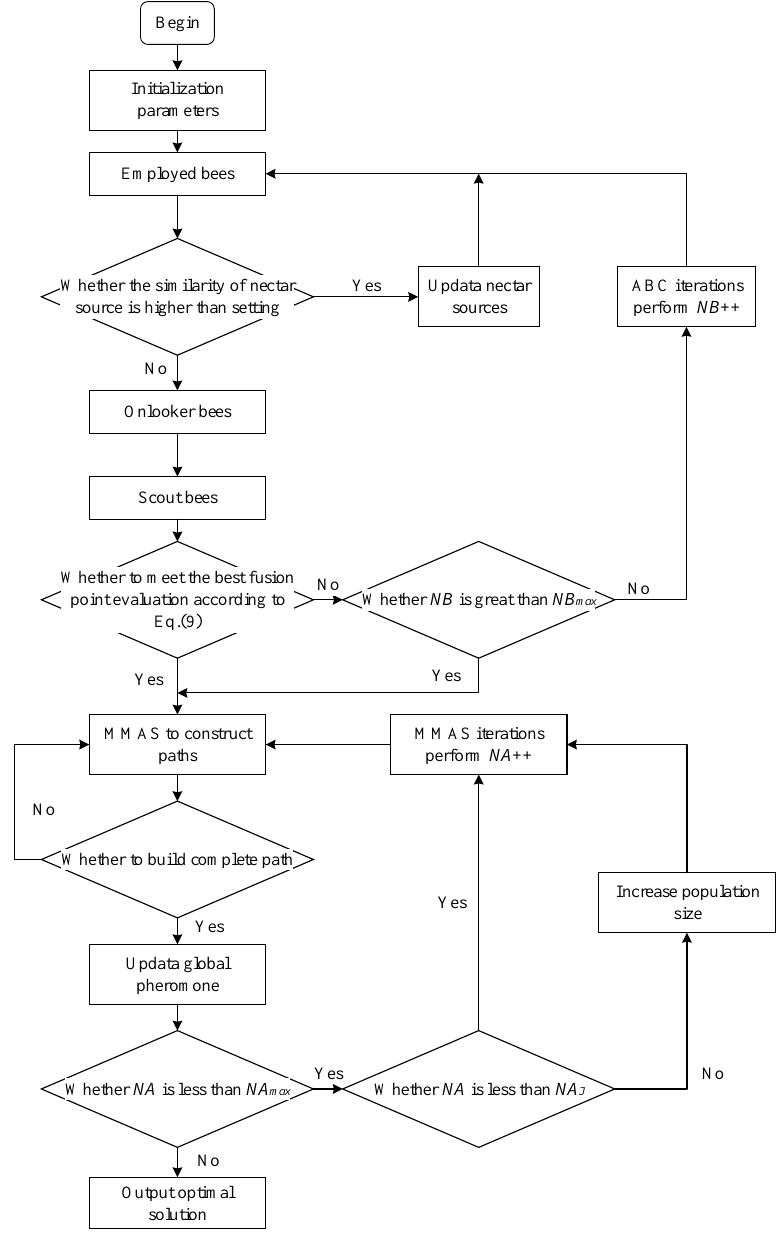
Figure 2. DABAA flow